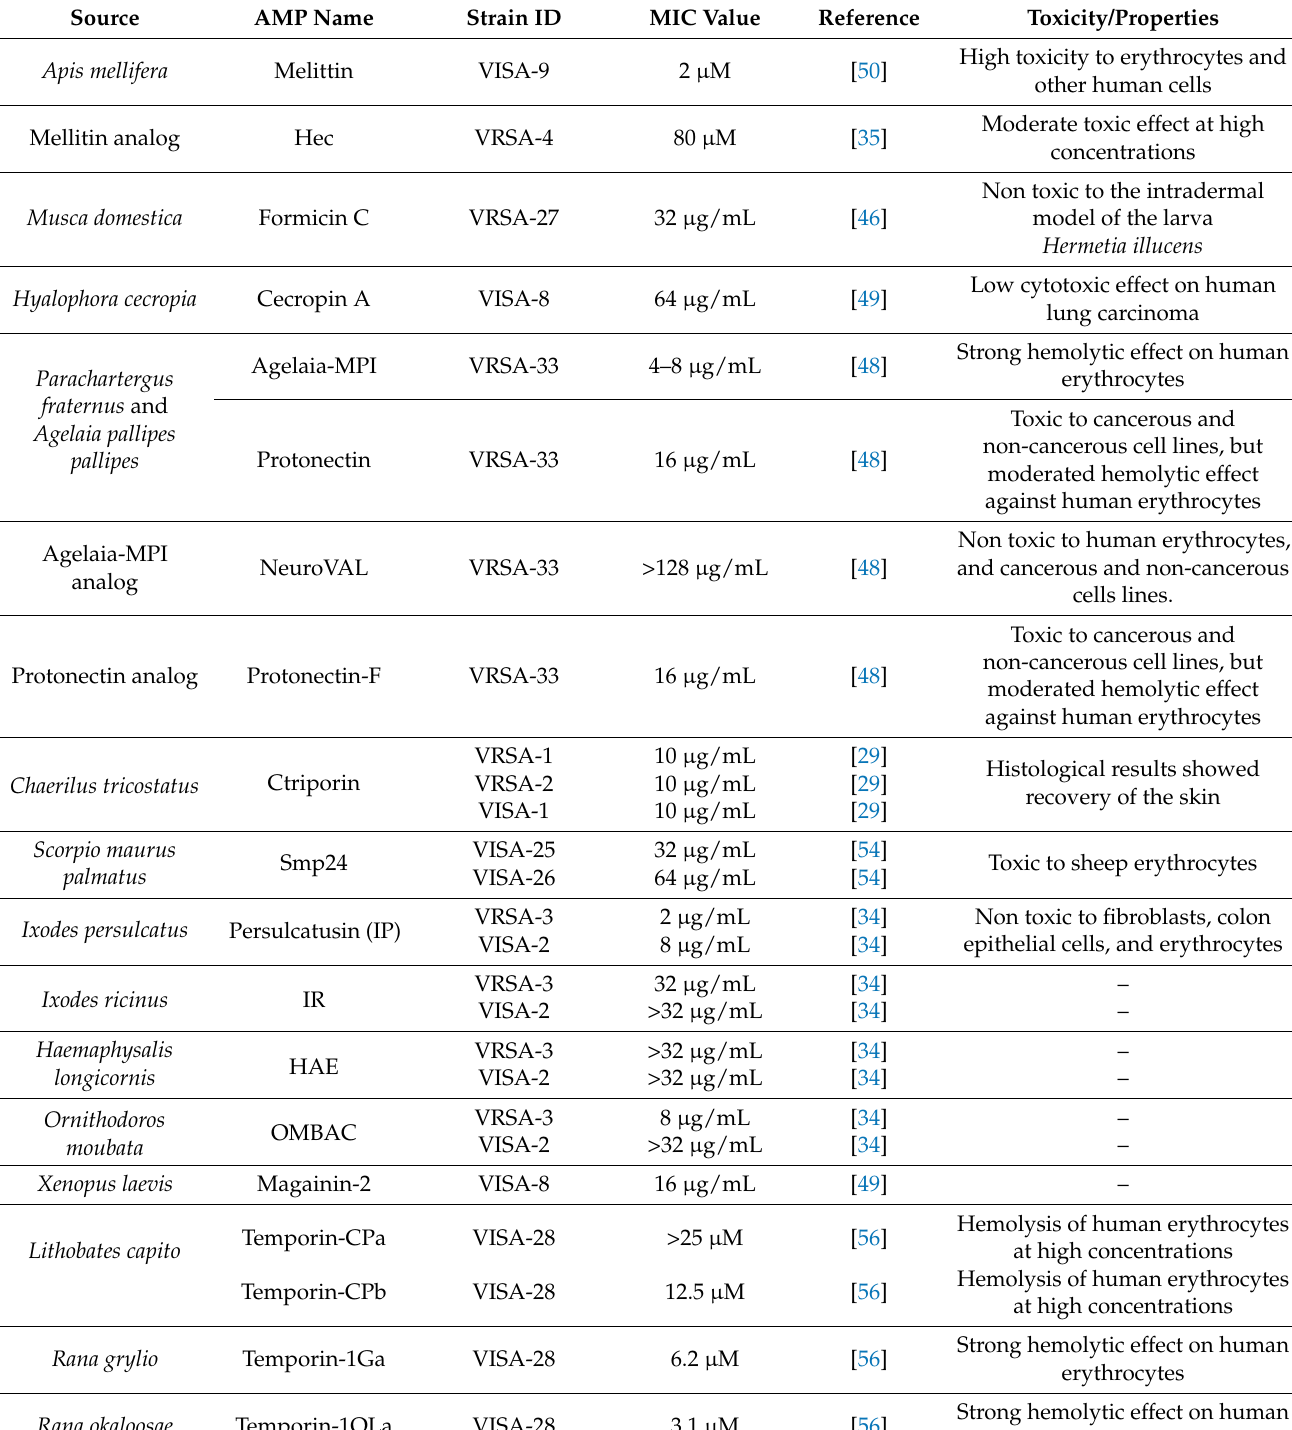
Table 2. Animal-derived AMPs with antibacterial activity against VRSA and VISA